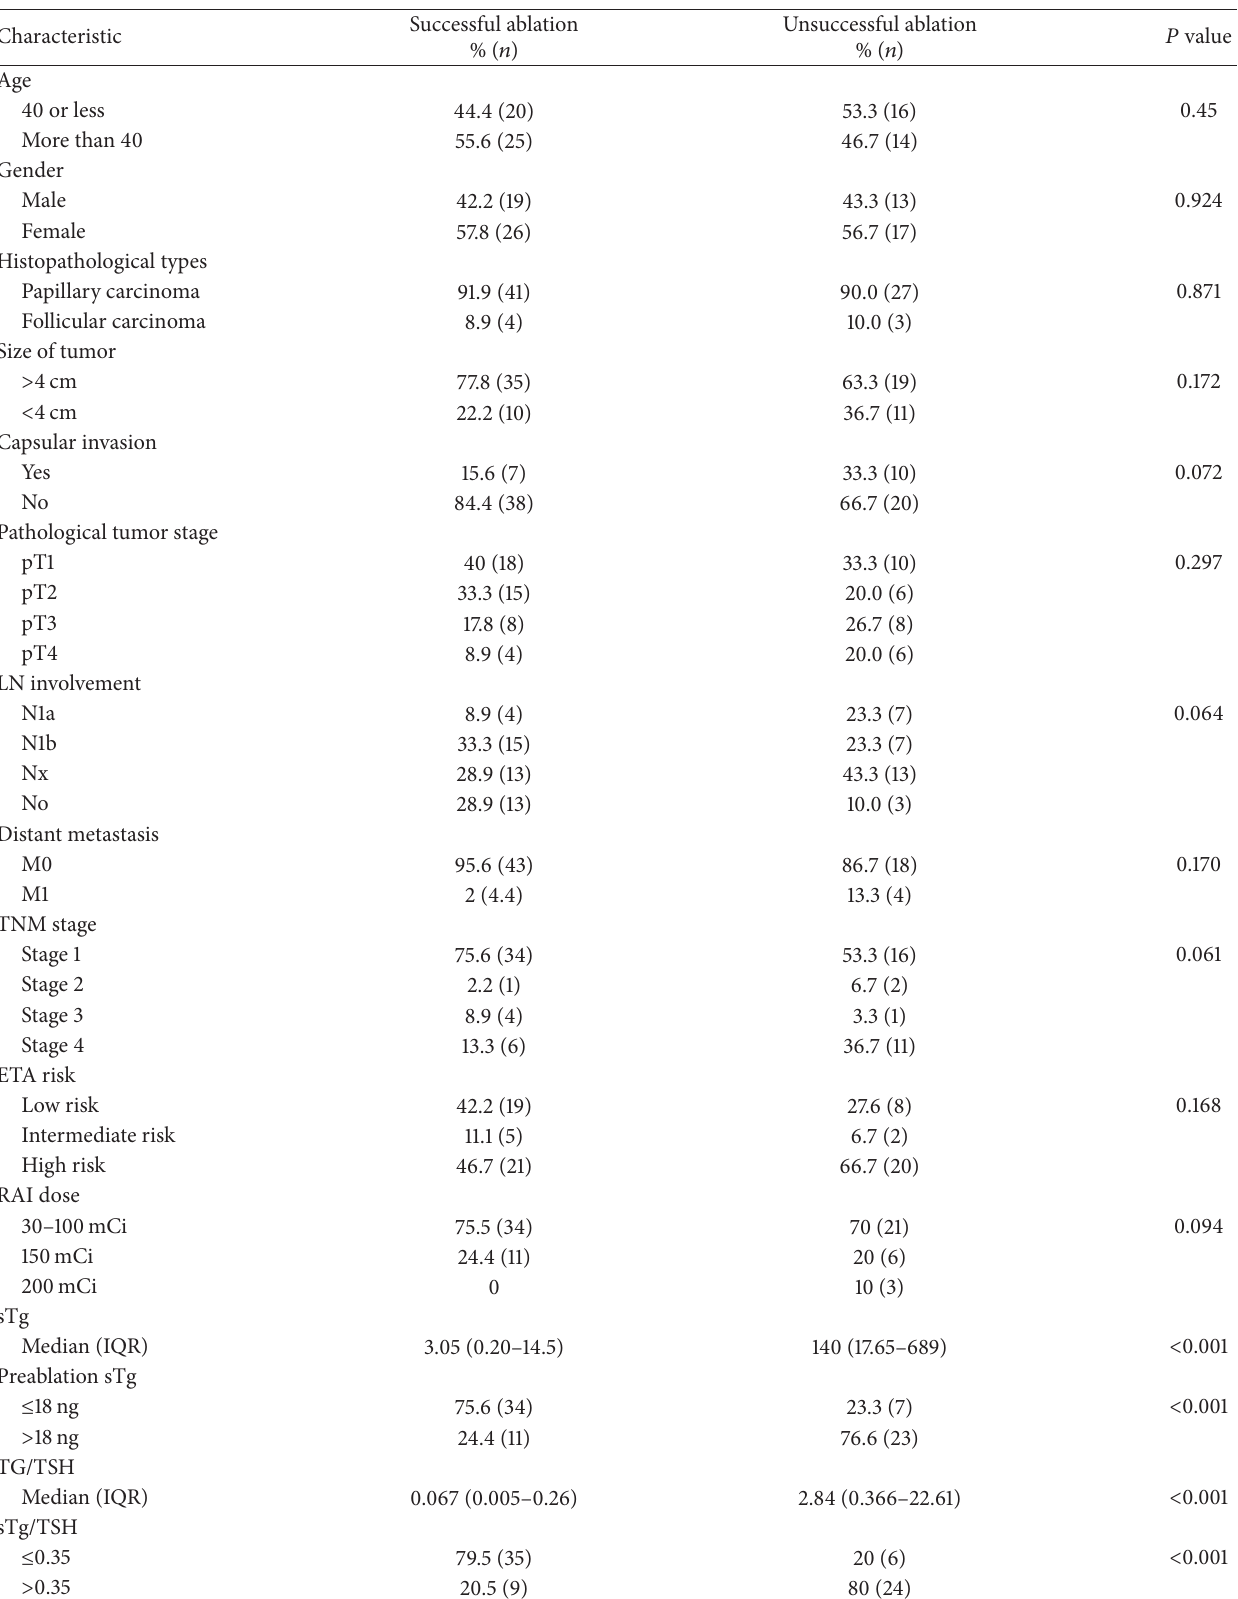
Table 1: Comparison of baseline characteristics of successful and unsuccessful